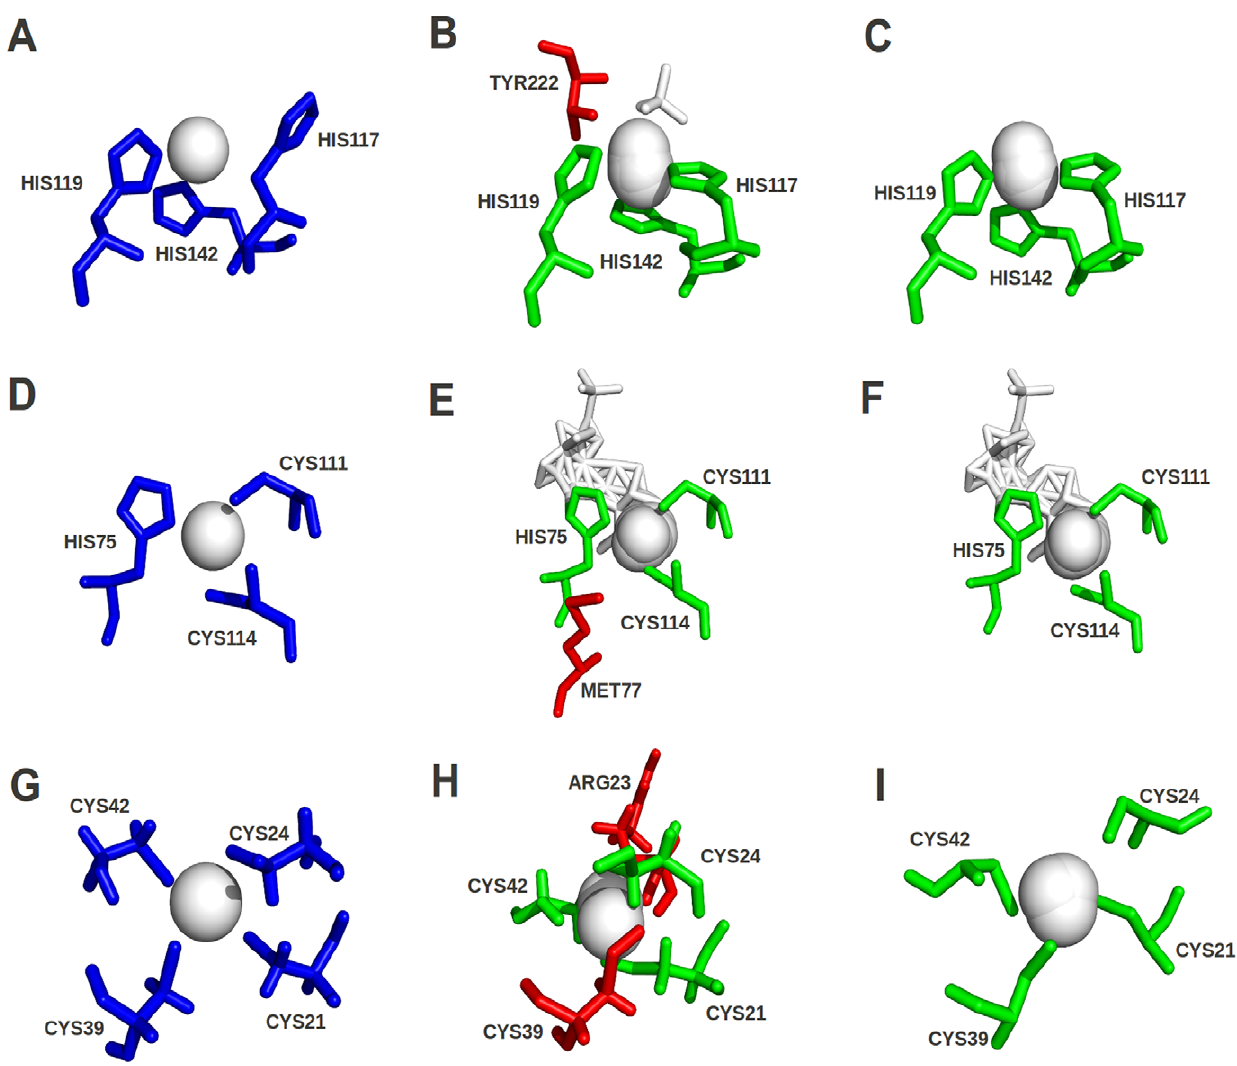
Figure 7. Examples of binding site predictions from CASP8 targets using the FunFOLDQA and FunFOLD methods. The green sticks represent residues in the model that has been correctly predicted as binding to the ligands. The red sticks represent residues that were not predicted or incorrectly predicted as potential ligand binding residues. The blue sticks represent the observed ligand binding site residues in the experimental structure. The white spheres and the white sticks represent ligands either predicted (B, C, E, F, H and I) or observed (A, D and G). A) An example of the observed CASP8 target T0426 (3da2), with the observed binding site residues (117, 119 and 142) and ligands (ZN) shown. B) The predicted binding site from FunFOLD for T0426 with the predicted binding site residues (117, 119, 142 and 222) and ligands (ZN-19 and SO 4 -1) shown. C) An example where FunFOLDQA produces a perfect prediction for CASP8 target T0426 (3da2), with the predicted binding site residues (117, 119 and 142) and ligands (ZN-19 and SO 4 -1) shown. D) An example of the observed CASP8 target T0461 (3dh1), with the observed binding site residues (75, 111 and 114) and ligands shown (ZN). E) The predicted binding site from FunFOLD for T0461 with the predicted binding site residues (75, 77, 111 and 114) and ligands (ZN-17, IMD-1, DDN-1, PO 4 -1 and THU-1) shown. F) An example where FunFOLDQA produces a perfect prediction for CASP8 target T0461 (3dh1), with the predicted binding site residues (75, 111 and 114) and ligands (ZN-17, IMD-1, DDN-1, PO 4 -1 and THU-1) shown. G) An example of the observed CASP8 target T0480 (2k4k), with the observed binding site residues (21, 24, 39 and 42) and ligands (ZN) shown. H) The predicted binding site from FunFOLD for T0480 with the predicted binding site residues (21, 23, 24 and 42) and ligands (ZN-2) shown. I) An example where FunFOLDQA produces a perfect prediction for CASP8 target T0480 (2k4k), with the predicted binding site residues (21, 24, 39 and 42) and ligands (ZN-3)